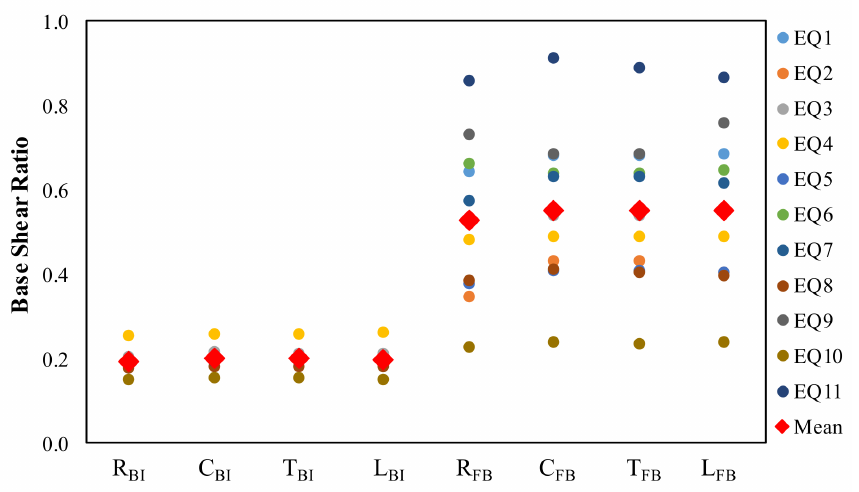
Figure 19. Base shear ratio for isolated- and fixed-base R, C, T, and L models.